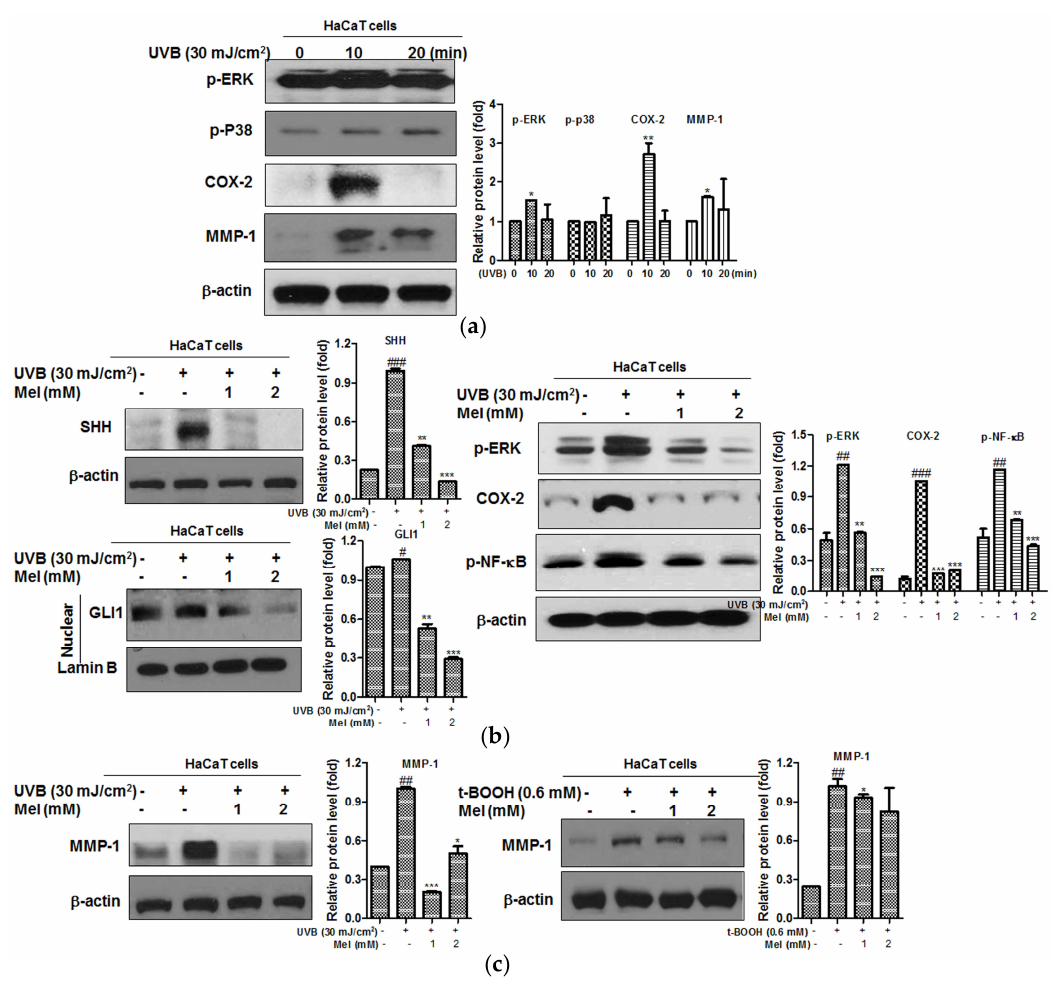
Figure 4. The melatonin attenuated the expression of SHH, GLI1 and MMP-1 related proteins in t-BOOH or UVB treated HaCaT keratinocytes. ( a ) HaCaT cells were exposed to UVB (30 mJ/cm 2 ) for 10 min or 20 min and subjected to Western blotting for p-ERK, PP38, COX-2, MMP-1 and β-actin. ( b) , ( c ) Cells were pretreated with melatonin for 24h, irradiated with UVB (30 mJ/cm 2 ) for 10 min and then subjected to Western blotting for SHH, GLI1 (nuclear fraction), p-ERK, COX-2, p-NF- κ B, MMP-1, β -actin and Lamin B. Cells were pretreated with melatonin for 24 h and then with t-BOOH (0.6 mM) for 6 h. Graphs represent quantitative analysis of protein expression adjusted by β -actin. Data represent means ± SD. *** p < 0.001, ** p < 0.01 and * p < 0.05 versus UVB control, ### p < 0.001, ## p < 0.01 and # p < 0.05 versus normal